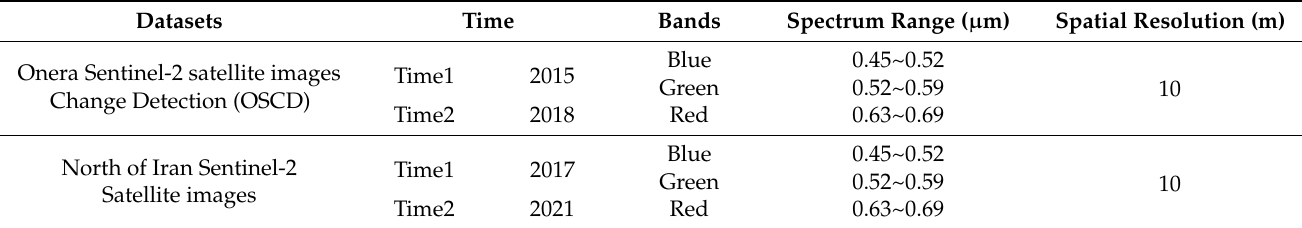
Table 3. Information on datasets used in this study.